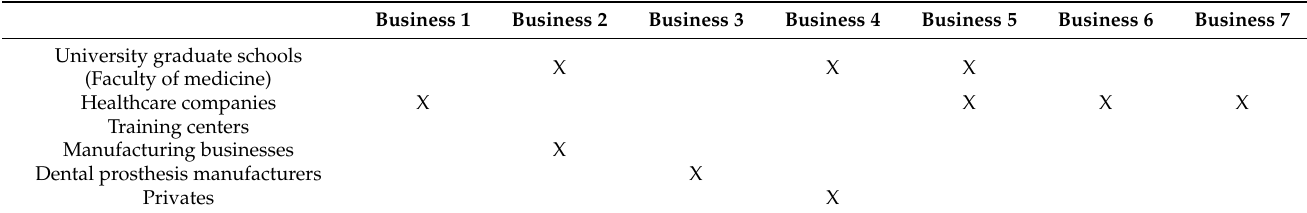
Table 3. Businesses’ main customers.